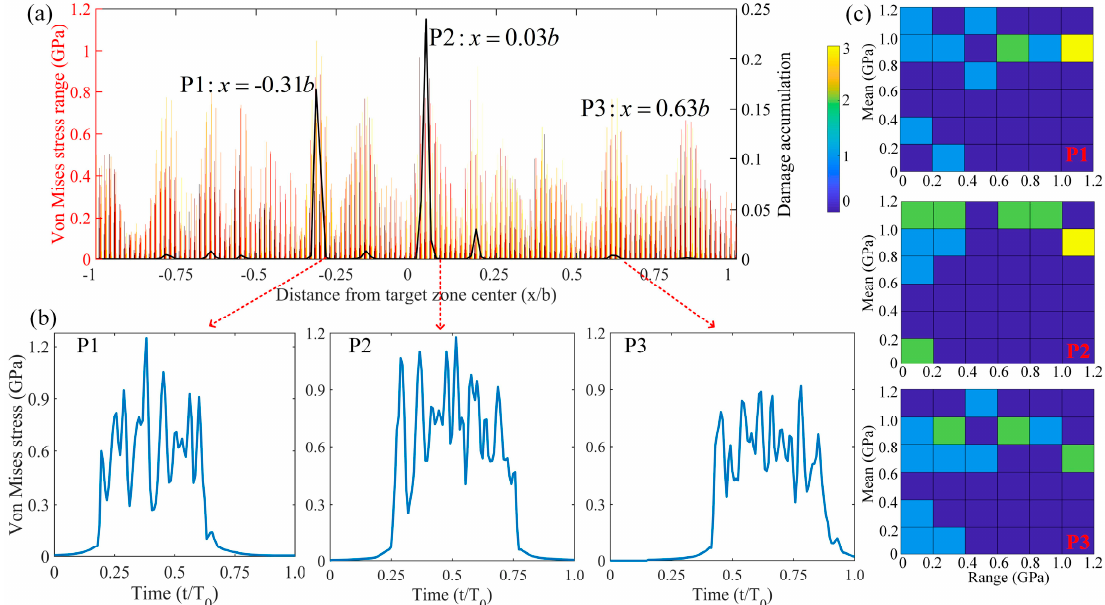
Figure 9. ( a ) Distribution of stress range and damage accumulation, ( b ) stress history at different contact position, ( c ) stress spectrum at different contact position.